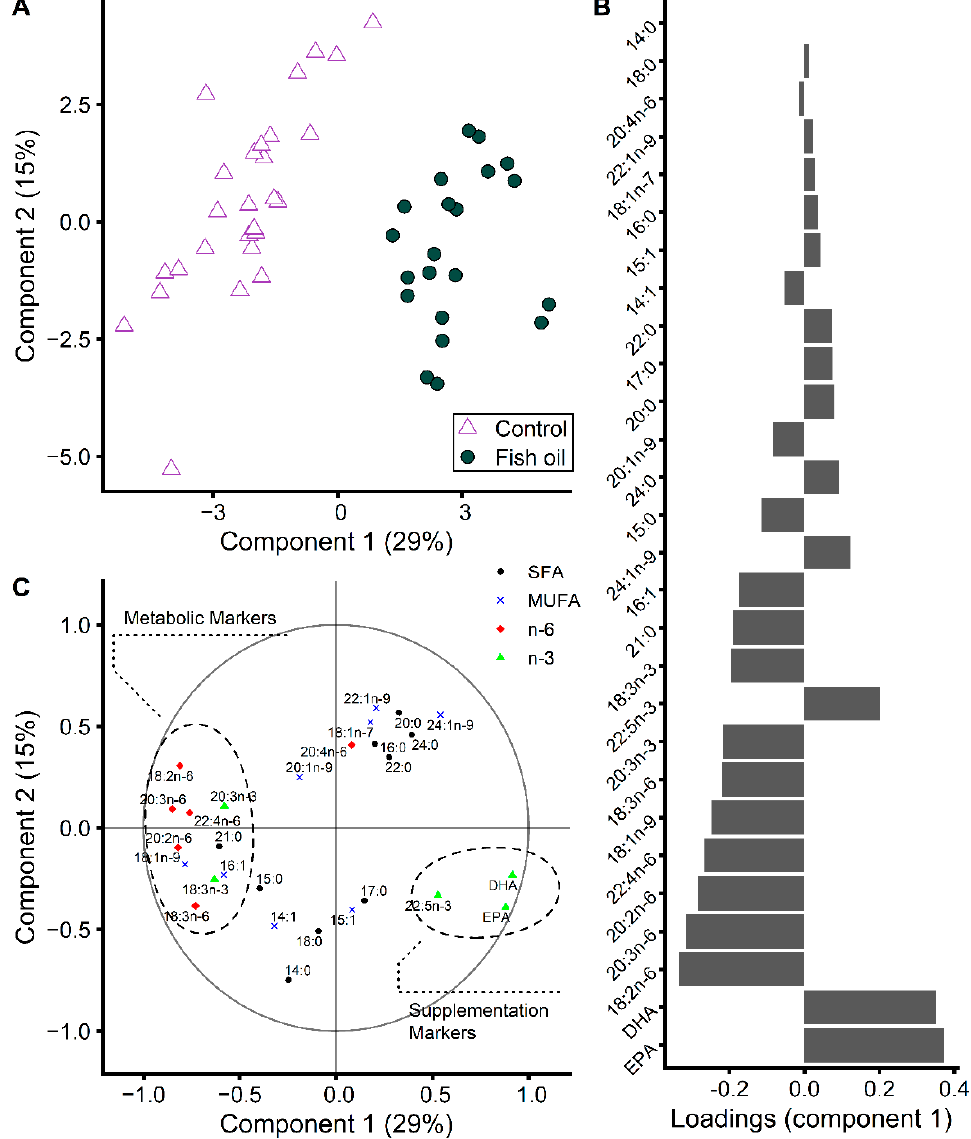
Figure 7. A partial least squares discriminant analysis was performed to further assess, explore, and highlight how changes in fatty acid levels relate to intake and metabolic differences between groups of advanced breast cancer patients who complied with fish oil supplementation ( n = 21) or with a control supplementation ( n = 27) during the first 10 days of the trial. ( A ) Score plot. ( B ) Variable correlation plot. ( C ) Loadings on the first component. Input variables are the differences between fatty acid area% at 10 days and baseline. EPA, eicosapentaenoic acid (20:5n ‐ 3); DHA, docosahexaenoic acid (22:6n ‐ 3); SFA, saturated fatty acids; MUFA, monounsaturated fatty acids.